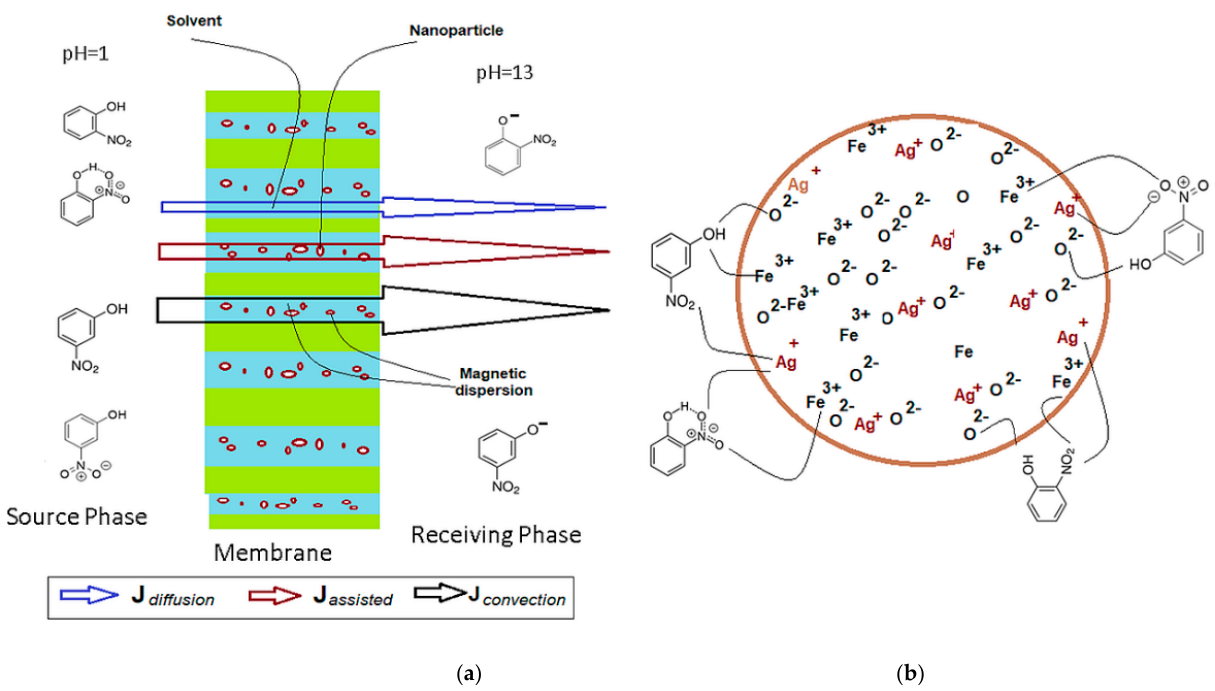
Figure 11. The pertraction mechanism through supported liquid membranes. (a) membrane system and specific fluxes (J); (b) assisted nanoparticle transport mechanism for m - and o - nitrophenol.